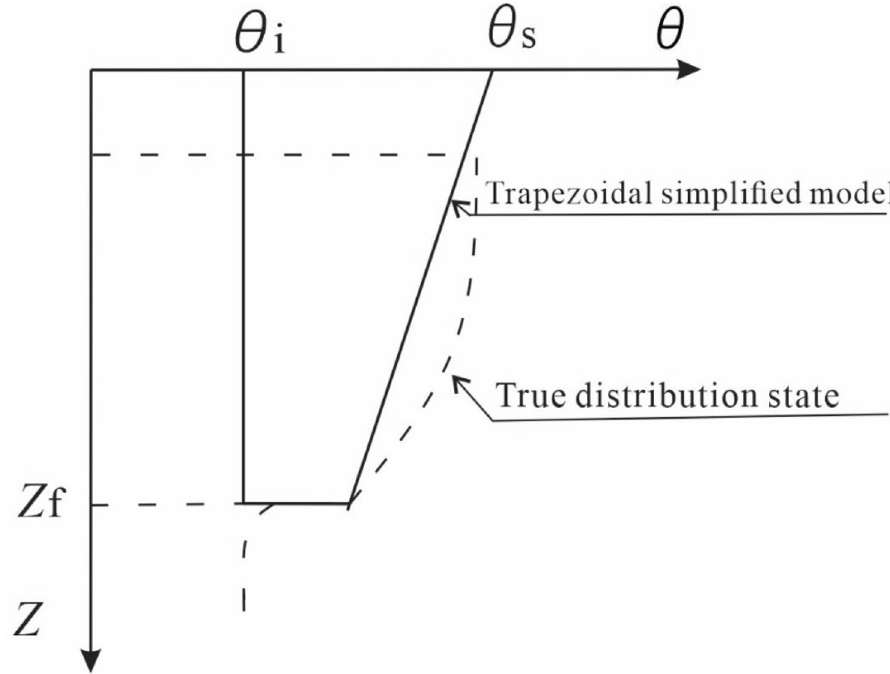
Figure 2. Simplified moisture content diagram of soil